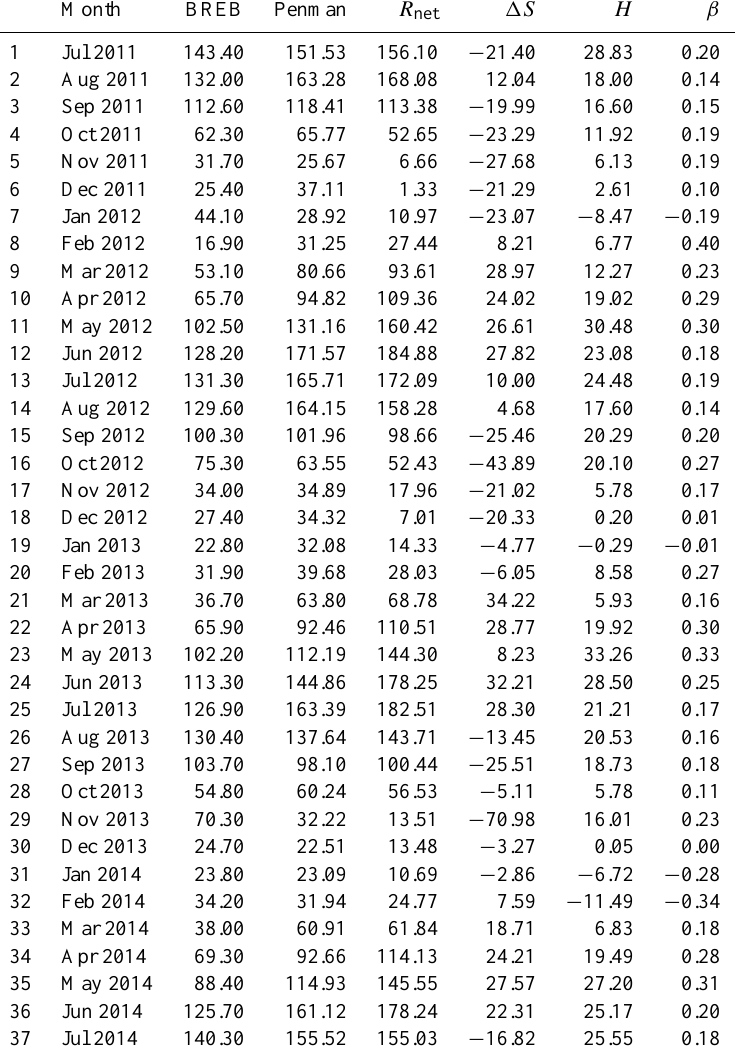
Table 1. Monthly evaporation for BREB and Penman with other terms of the heat budget and Bowen ratio. Units are Wm − 2